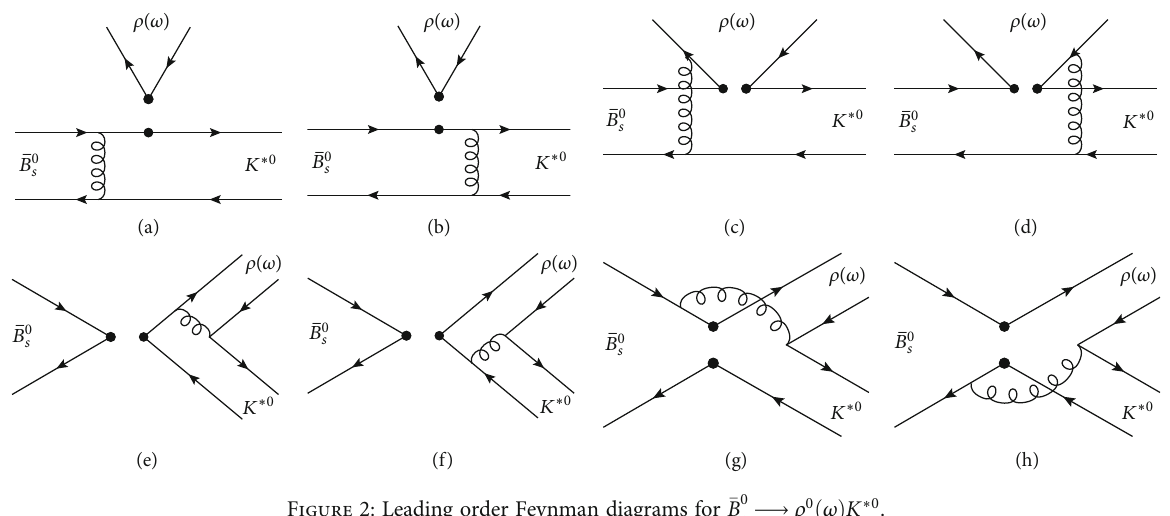
Figure 2: Leading order Feynman diagrams for (cid:1) B 0